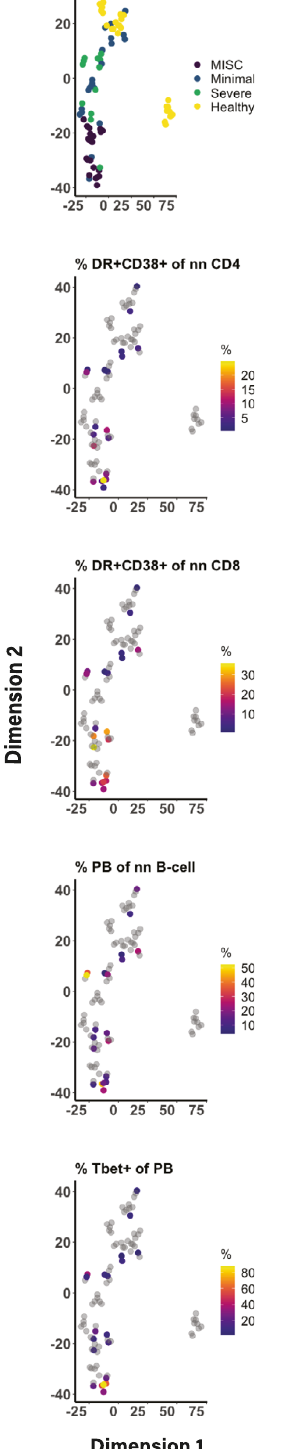
plasma shortly after treatment does not immediately affect this analyte. Levels of PLA2G2A and IFN γ (Supplementary Fig. 1e, f) did eventually decay over time following treatment. We also examined the impact of treatment in all proteins in Supplemen- tary Fig. 2f. Samples drawn prior to or immediately after receiving treatment did not cluster separately from each other, implying minimal differences in the short-term following treatment.